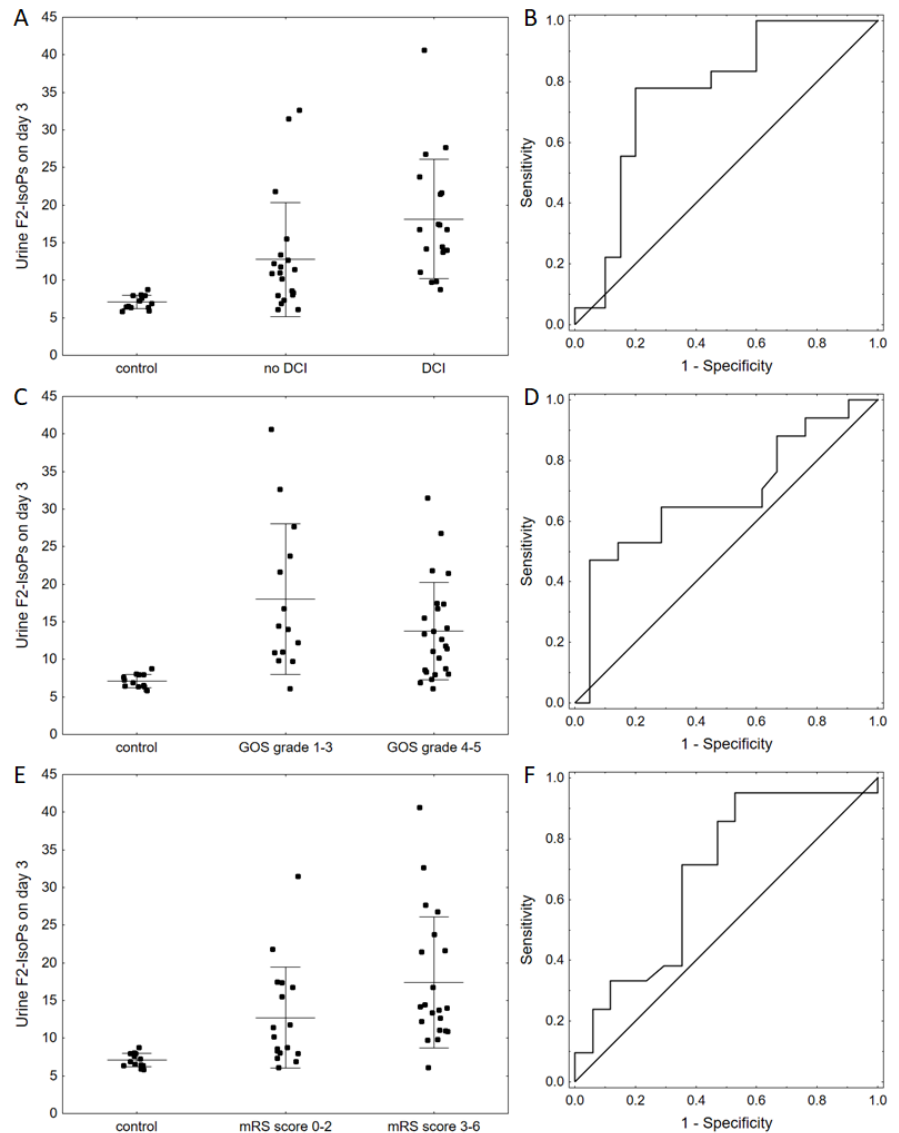
Figure 2. Differences in F2-isoprostane urine levels between different groups of patients; dots and lines show means ± SD ( A ) A plot for the control group and aneurysmal subarachnoid hemorrhage (aSAH) patients with and without delayed cerebral ischemia (DCI) (control vs. aneurysmal subarachnoid hemorrhage: p < 0.001 for ANOVA; p < 0.05 for all comparisons; DCI vs. no DCI: p = 0.023). ( B ) Receiver operating characteristic curve for DCI prediction by F2-isoprostane levels on day 3 (area under the curve (AUC) 0.764, 95% CI: 0.606–0.922; p = 0.001 optimal cutoff: threshold 13.8, sensitivity—0.778, specificity—0.800). ( C ) A plot for clinical condition of the patients 12